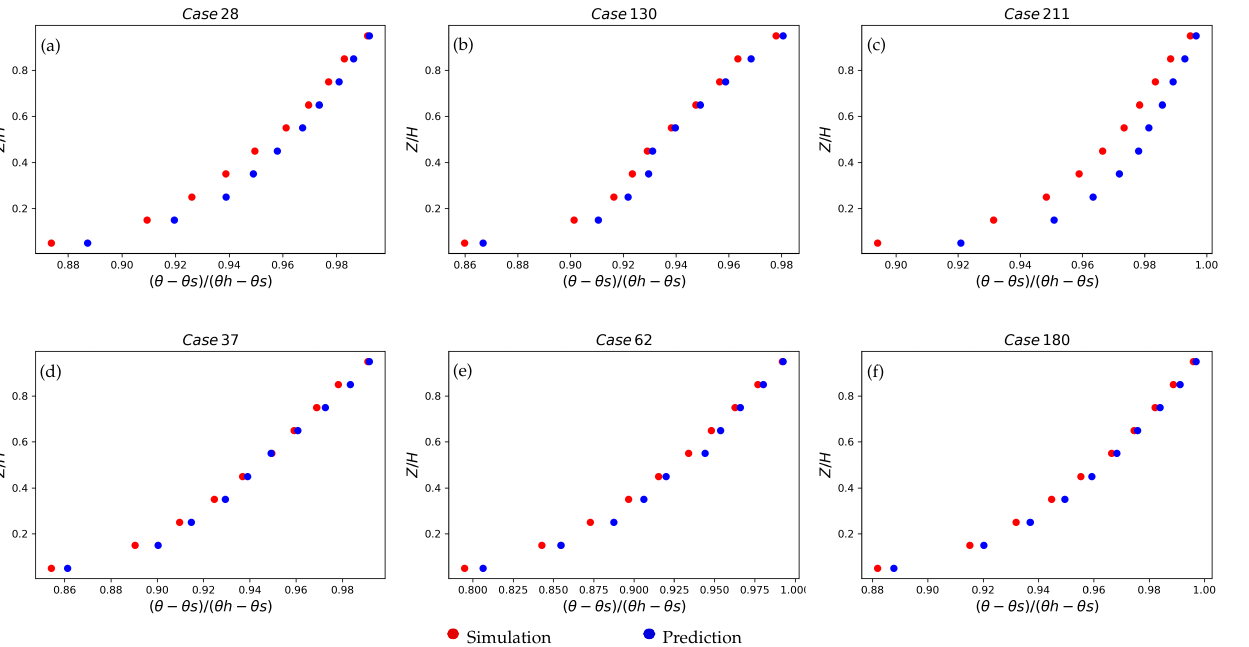
Figure 16. Temperature discrete points’ prediction: simulation data vs. ANN for unstable cases ( a – c ) and stable cases ( d – f